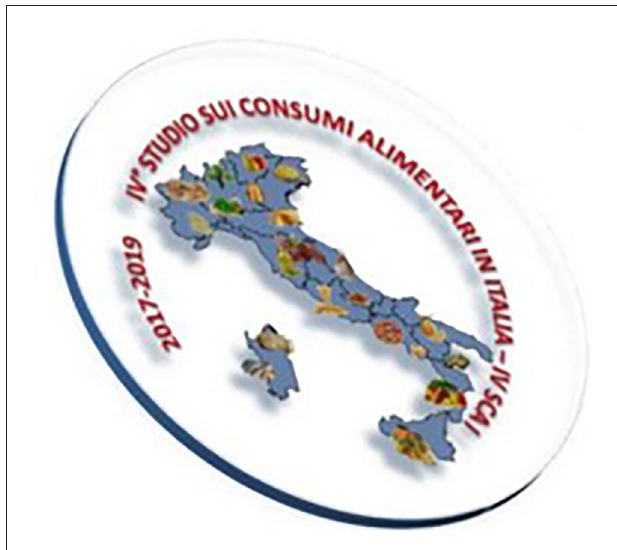
FIGURE 2 | IV study on food consumption in Italy (IV SCAI).